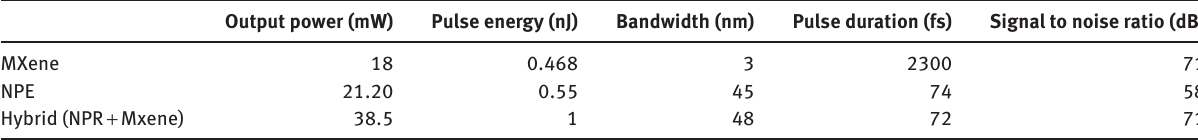
Table 1: Performance summary of Yb-doped mode-locked fiber lasers using saturable absorber